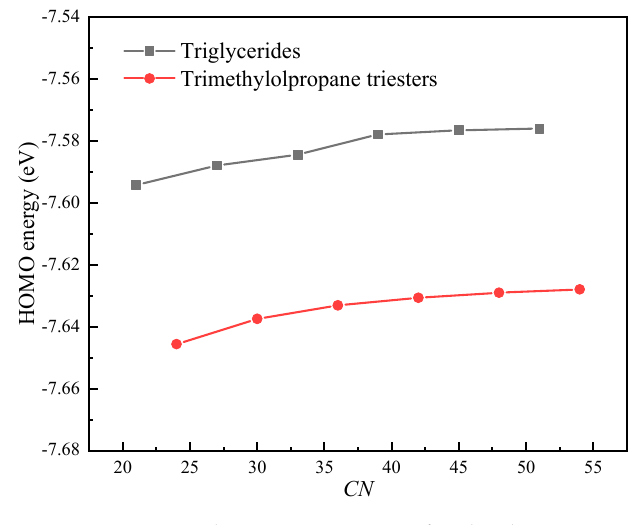
Figure 6. The HOMO energies of molecules.